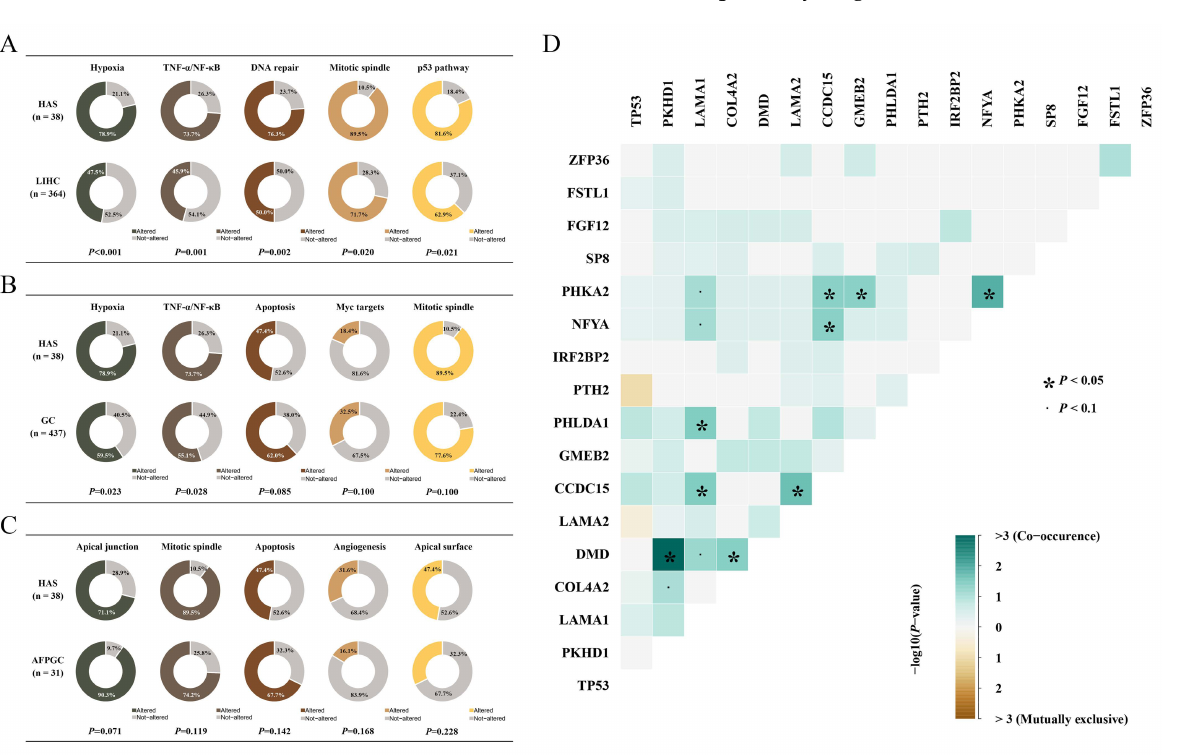
Figure 2. The proportion of mutated pathways. The proportion of patients with mutated genes in the described pathways and its differences in ( A ) HAS vs. LIHC, ( B ) HAS vs. GC, and ( C ) HAS vs. AFPGC. The curated gene sets for each pathway are obtained from the GSEA database. ( D ) Co- occurrence or mutual exclusivity patterns for the SMGs and representative genes. p < 0.05 is statisti- cally